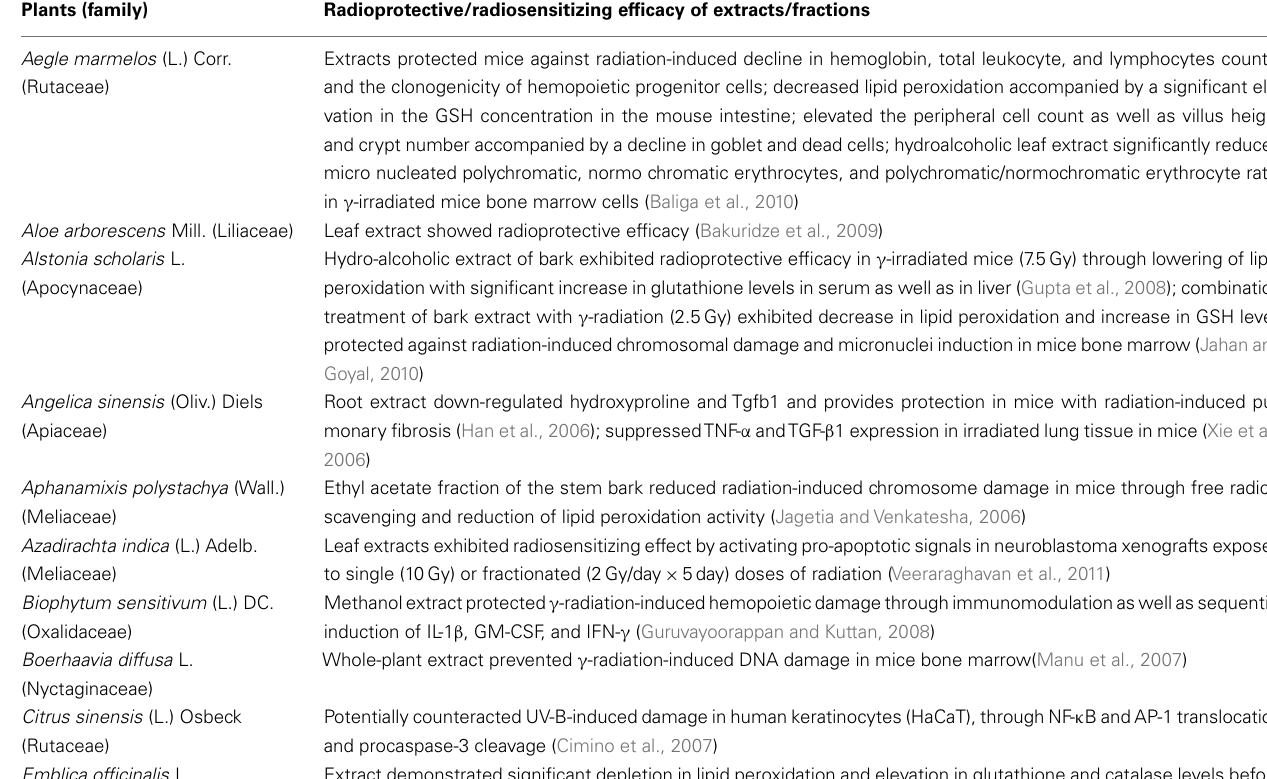
Table 1 |Traditional medicinal plants and/or their bioactive constituents with prospective radioprotective/radiosensitizing efficacy (2006–2011). Plants (family) Radioprotective/radiosensitizing efficacy of extracts/fractions Aegle marmelos (L.)